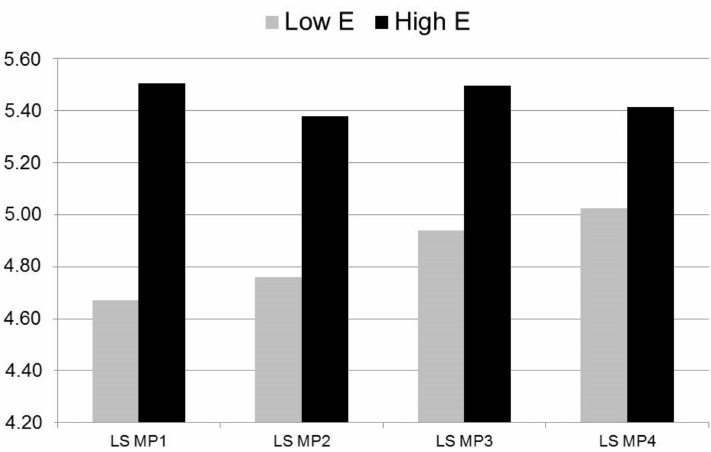
Figure 3. Mean scores in life satisfaction of students with above average and below average Extraversion at